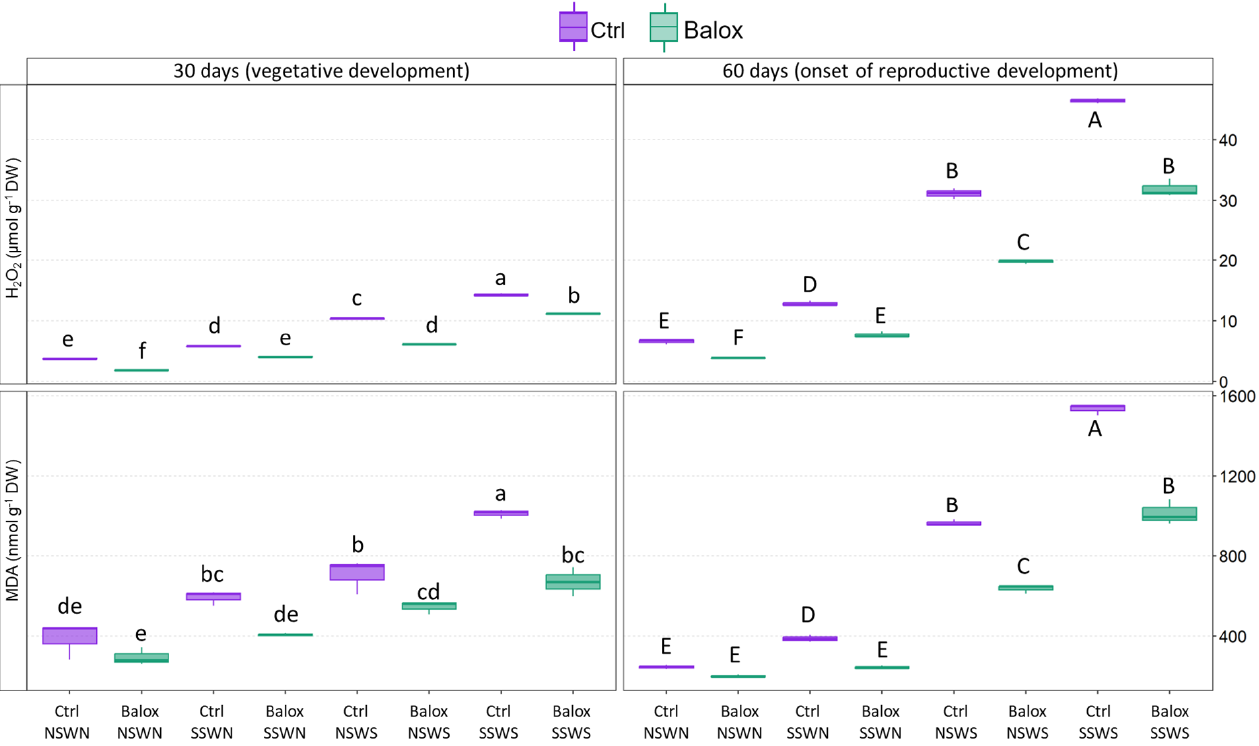
Figure 9. Hydrogen peroxide (H 2 O 2 ) and malondialdehyde (MDA) contents in leaves of tomato plants subjected to increasing salinity by different combinations of saline or non-saline soil and irrigation water; the plants were treated, or not, with the biostimulant containing polyphenols at 1.4% ( w / w ) and glycine betaine at 3.0% ( w / w ) at a dose of 0.4 mL L − 1 of irrigation water. The control treatments without biostimulant (Ctrl) and the treatments with biostimulant (BALOX ® ) are defined as follows: (i) NSWN: Non-saline soil (EC = 2.28 dS/m) and non-saline water (EC = 0.91 dS/m); (ii) SSWN: Saline soil (EC = 8.55 dS/m) and non-saline water (EC = 0.91 dS/m); (iii) NSWS: Non-saline soil (EC = 2.28 dS/m) and saline water (EC = 10.50 dS/m); (iv) SSWS: Saline soil (EC = 8.55 dS/m) and saline water (EC = 10.50 dS/m). The evaluation periods: 30 days and 60 days of treatments. The values are the means ± SE ( n = 3). Different letters above the bars (lowercase for 30 days and capital for 60 days of treatments) indicate significant differences between treatments, according to the